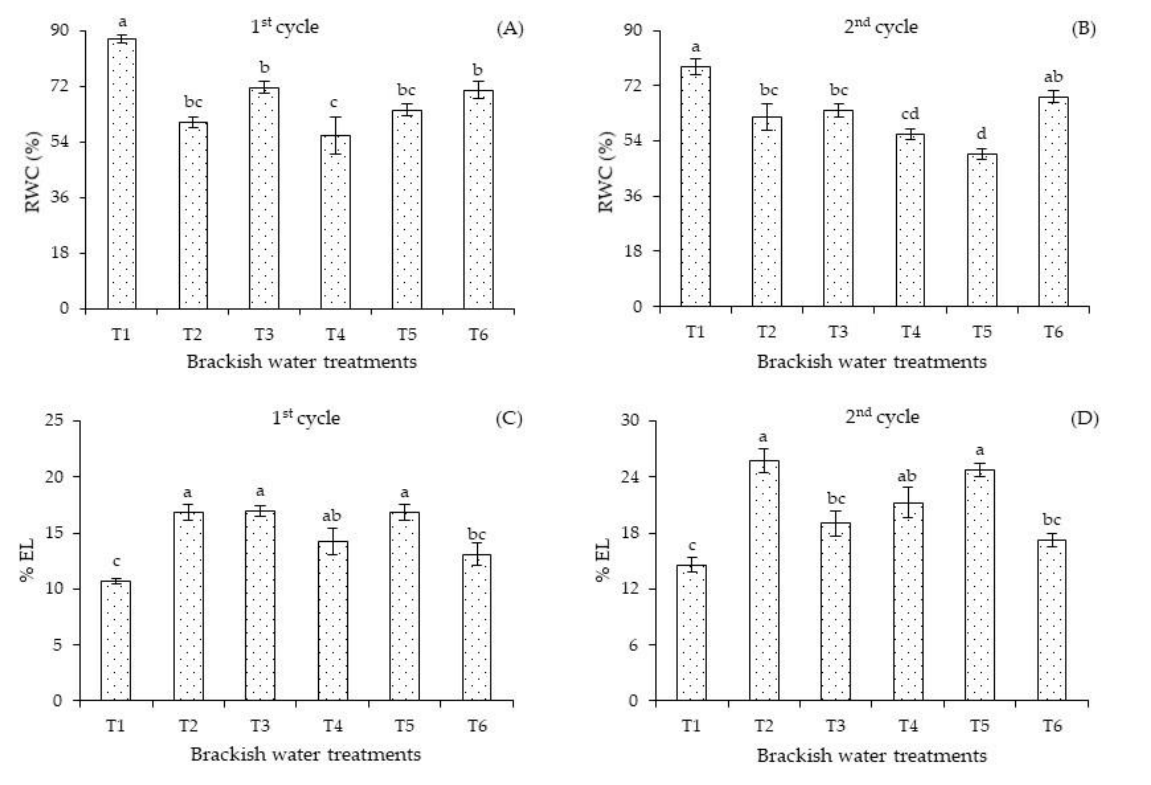
Figure 4. Relative water content—RWC ( A , B ) and electrolyte leakage—%EL ( C , D ) in Passiflora edulis Sims as a function of salt stress, varying the phenological stages in the first (240 DAT) and second (445 DAT) cycles. Standard error of the mean ( n = 8); Means followed by different letters indicate a